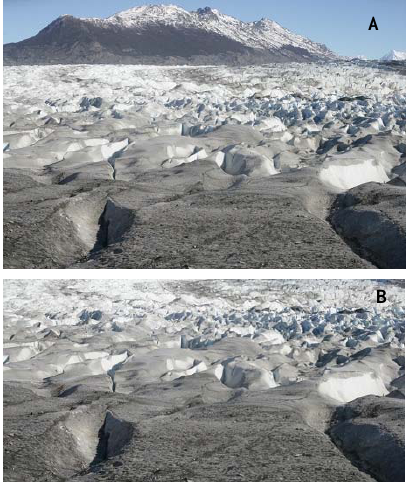
Figure 4. Original and ROI reduced